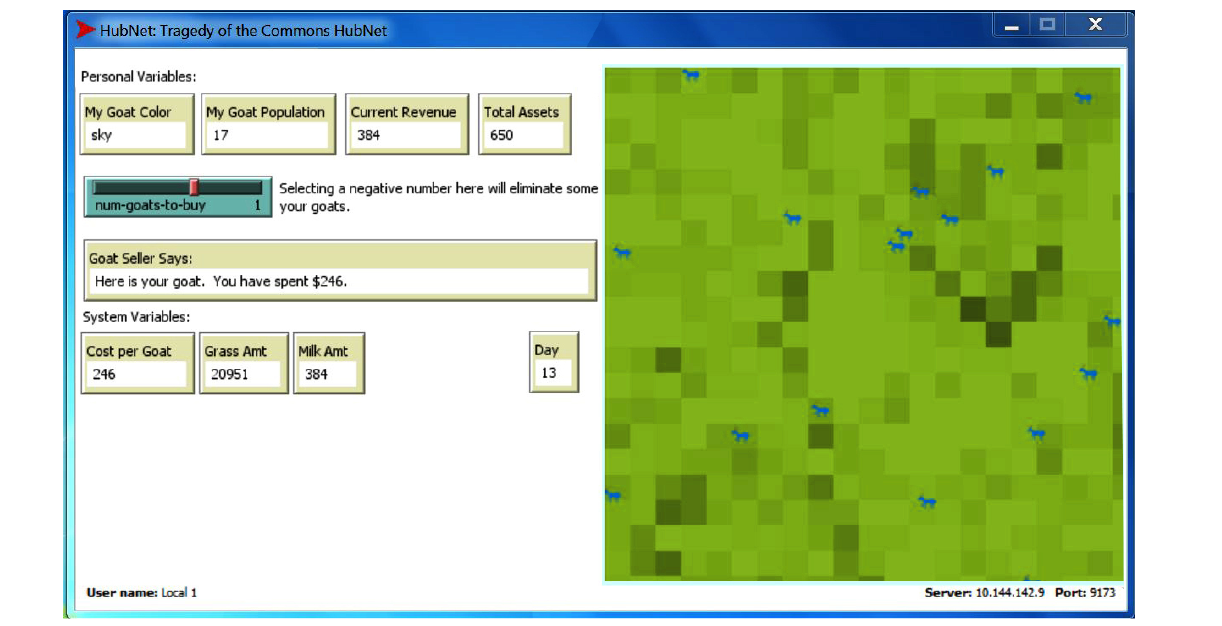
Fig. 11 . A screenshot of the visualization of the HubNet functionality of